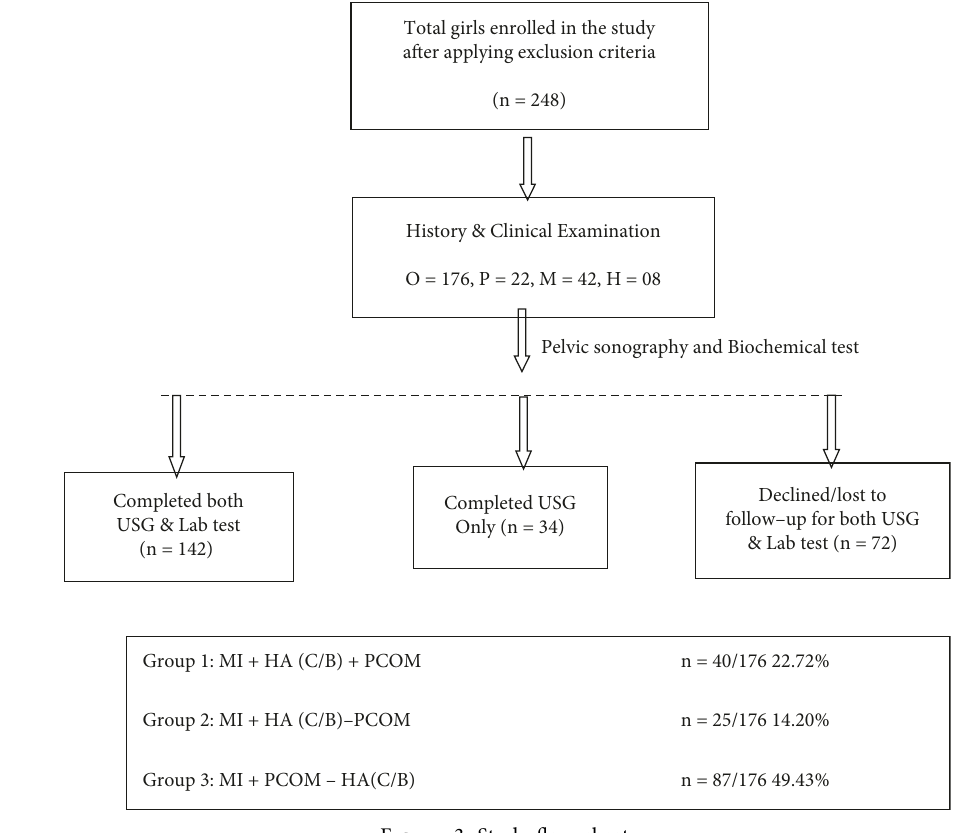
Figure 3: Study flow chart. Table 2: Endocrinal profile in adolescents with menstrual